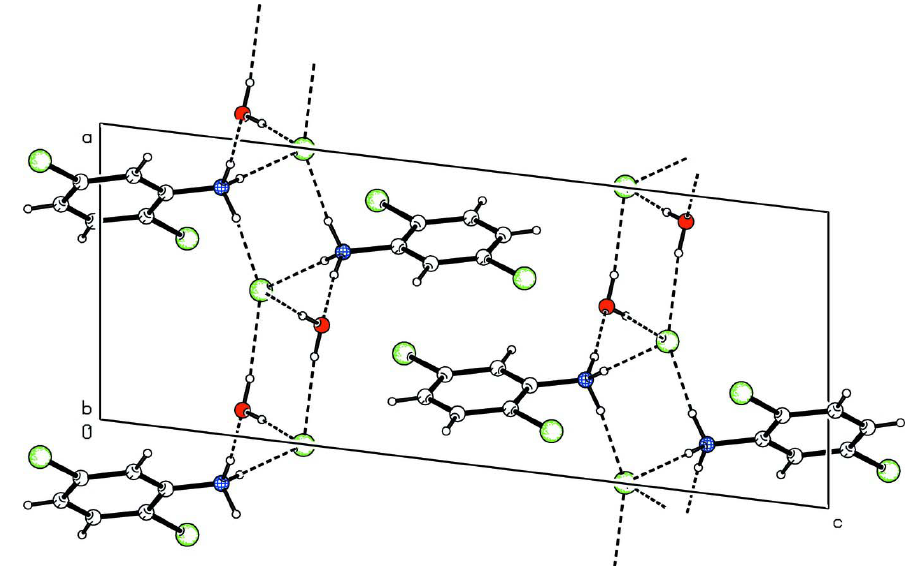
Figure 2 Molecular packing of the title compound with hydrogen bonding shown as dashed